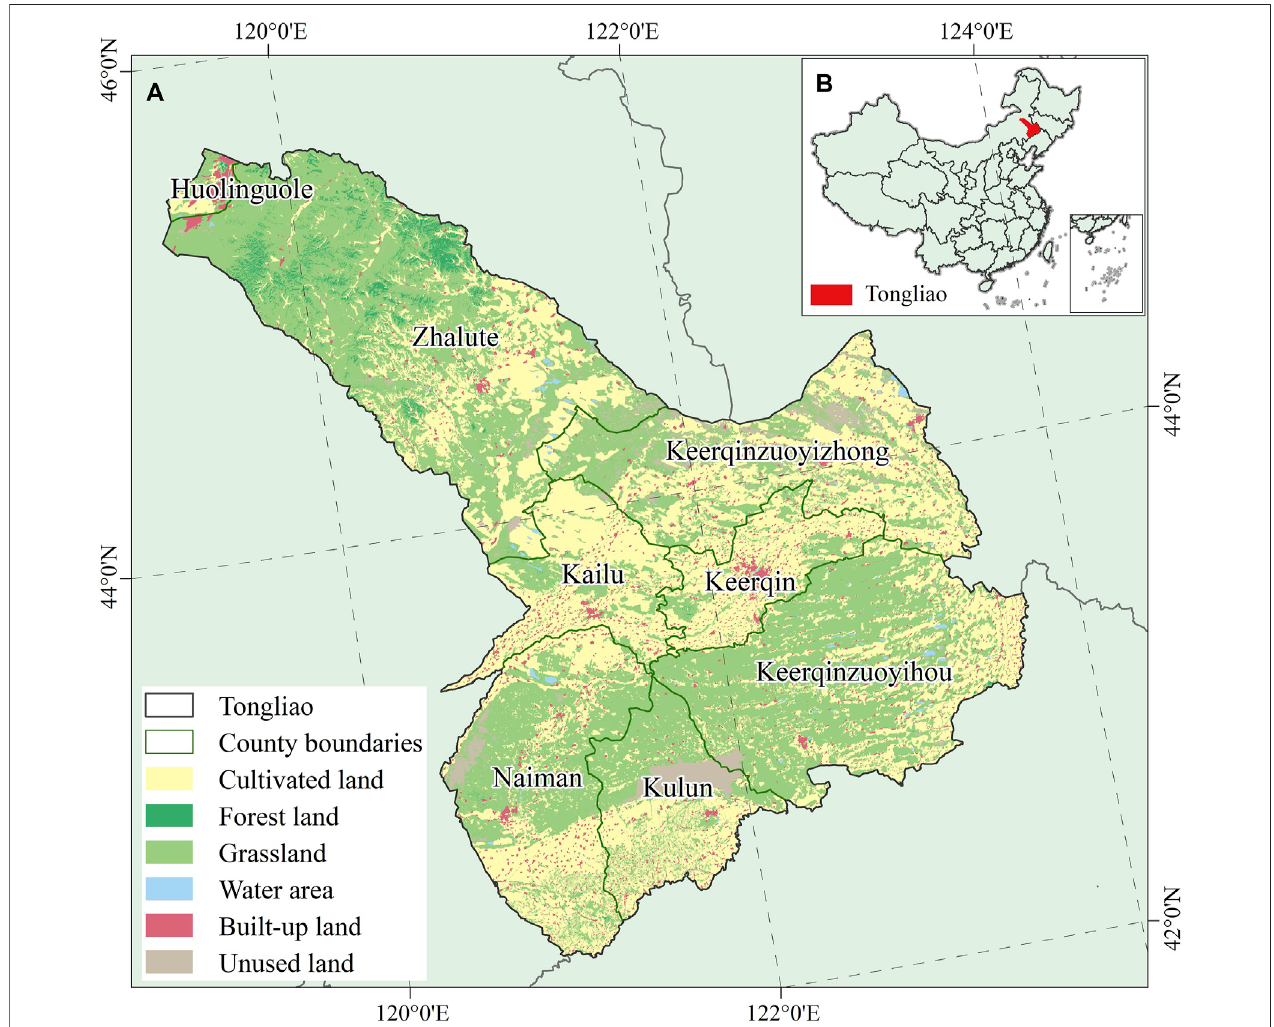
FIGURE 1 | Land use of study area (A) and its location in China (B)